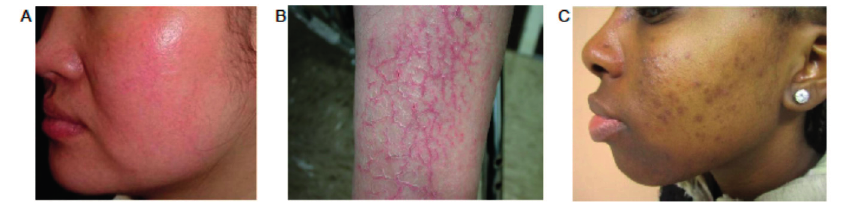
Figure 2. The aesthetic impact of inflammation. ( A ) A patient with persistent facial erythema due to rosacea. ( B ) Scale in a patient with atopic